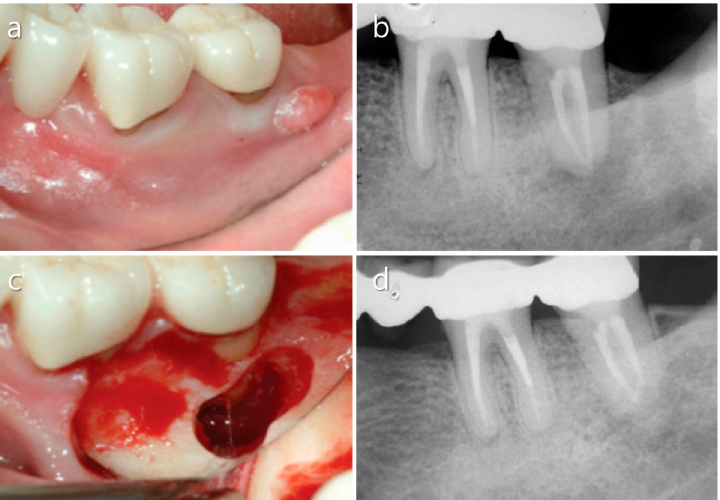
Figure 8. Endodontic surgery of a mandibular second molar. ( a ) Sinus tract formed on the buccal aspect of a left mandibular second molar. ( b ) Diagnostic periapical X-ray image showing that the tooth was an abutment for a fixed prosthodontic restoration. ( c ) The root apex was exposed after osteotomy. ( d ) A five-year follow-up radiograph shows complete bony healing. Images were modified from Song [31] after receiving permission from the journal.